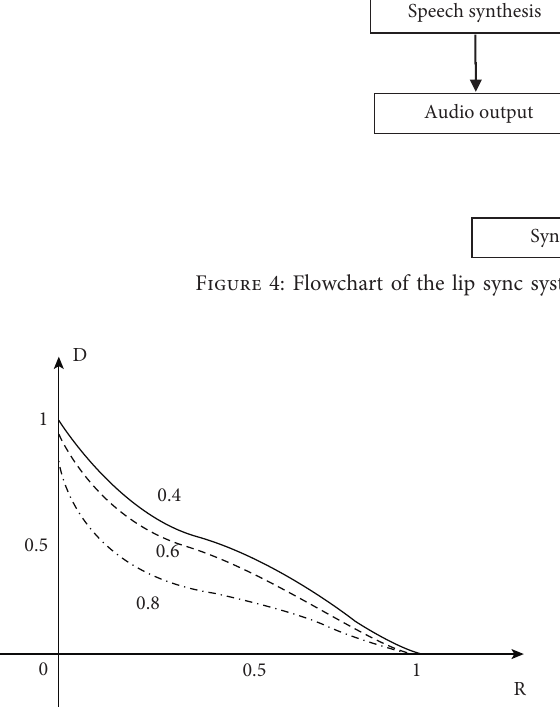
Figure 5: Relationship between the weight value and the influence on the consonants.